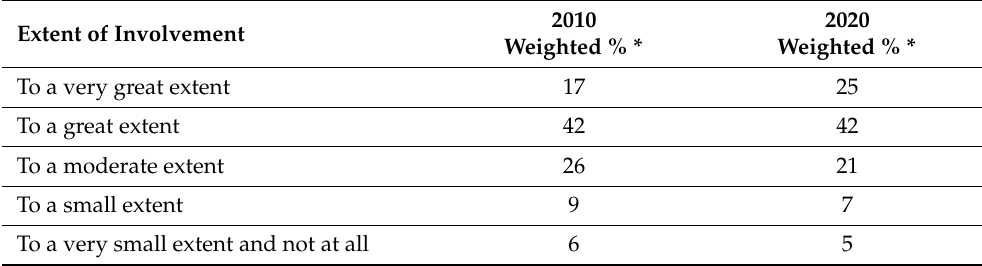
Table 2. Comparison of PCPs perceptions on nurses’ actual involvement contributes to the quality of practice by survey year (%).